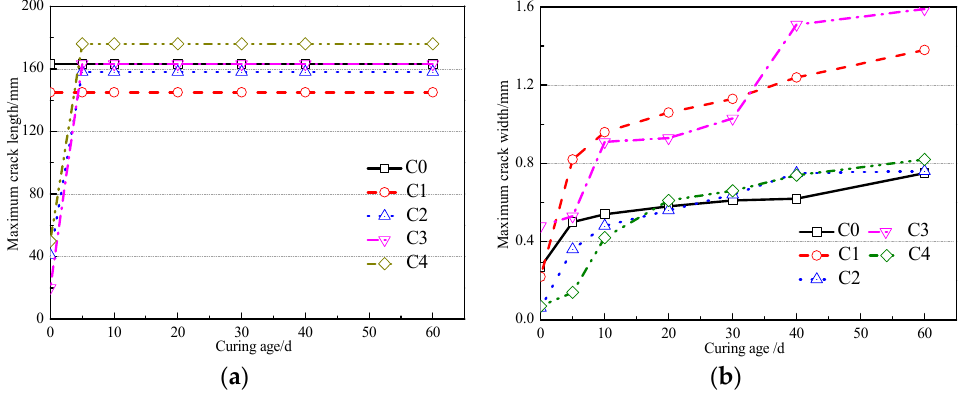
Figure 13. Relationship between maximum crack length, crack width, and curing age of NCM ring. ( a ) Maximum crack length; ( b ) maximum crack width.